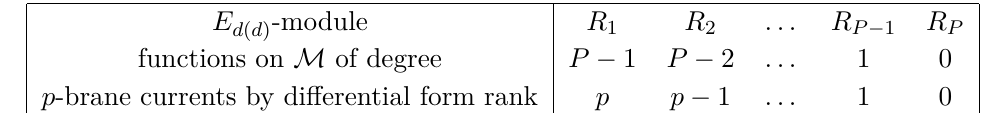
Table 2 . Tensor hierarchy modules, their corresponding functions on the QP-manifold M , and the associated brane currents (for real source Q-manifold N = T [1]Σ ). P = p + 1 is the degree of the symplectic structure ω on M ; p = dim Σ . For certain n, p, d , the R than the n -form current multiplet, as described in